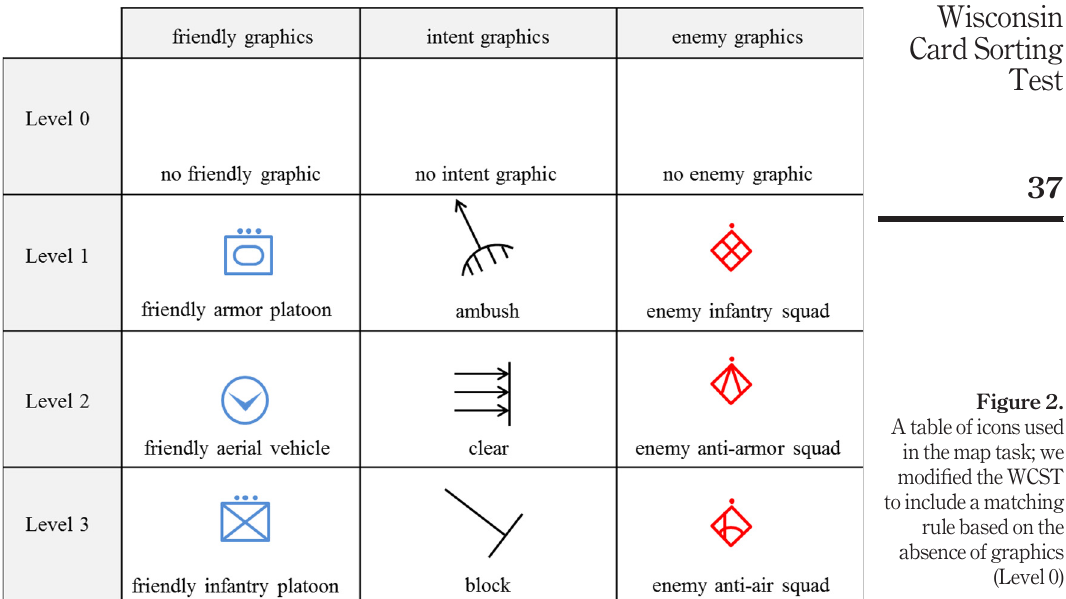
Figure 2. A table of icons used in the map task; we modi fi ed the WCST to include a matching rule based on the absence of graphics (Level